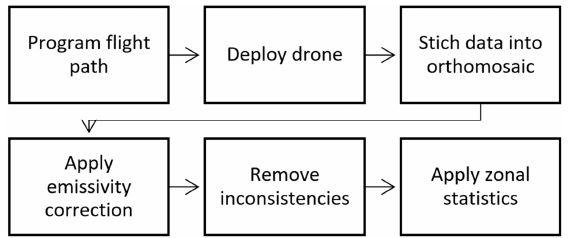
Figure 2. Flow chart of data collection and